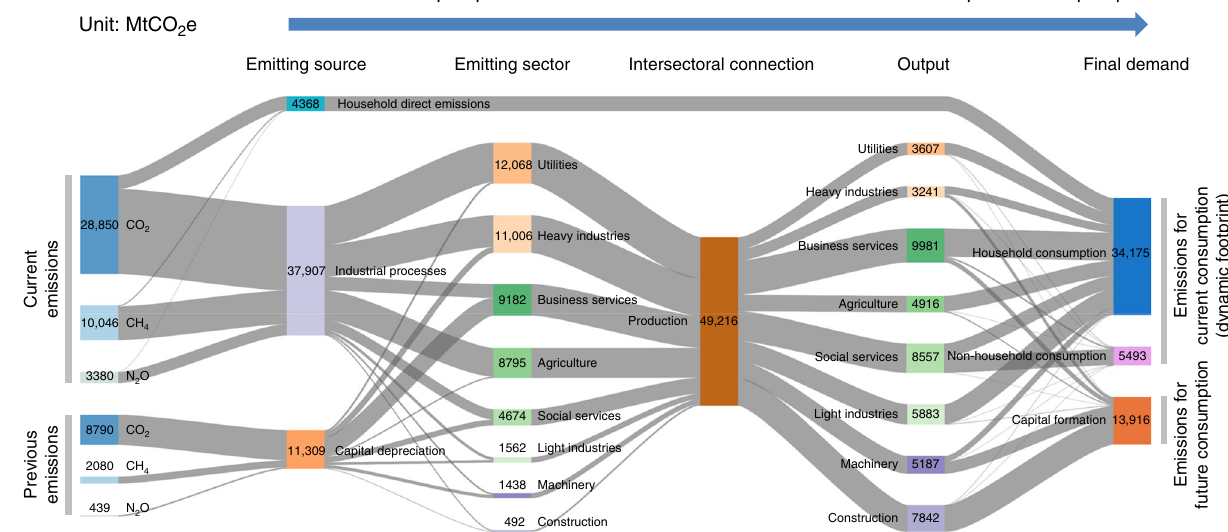
Fig. 3 Sankey diagram of embodied GHG fl ows of the world in 2009 under dynamic footprint accounting. Capital stock is shown to be an important source as well as destination of GHG fl ows. The industrial structure from production-based perspective is very different from that from consumption-based perspective. Sector de fi nition is reported in Supplementary Table